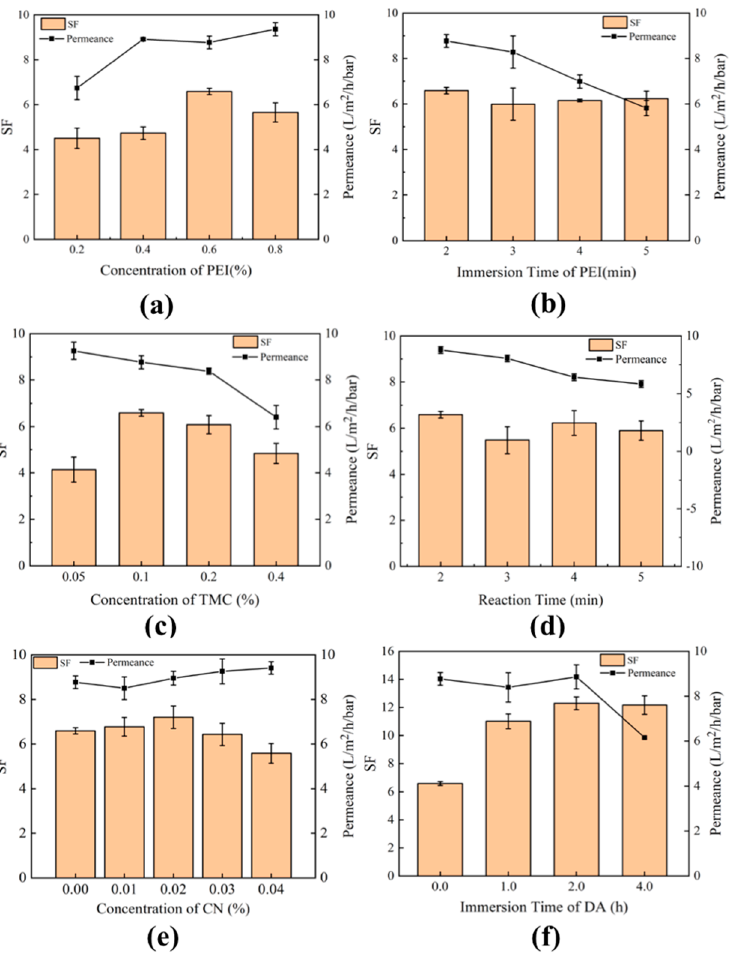
Figure 8. Effects of fabrication conditions on membrane separation performance and permeance. ( a ) PEI concentration; ( b ) immersion time of PEI; ( c ) TMC concentration; ( d ) reaction time; ( e ) g-C 3 N 4 concentration; ( f ) immersion time of DA.